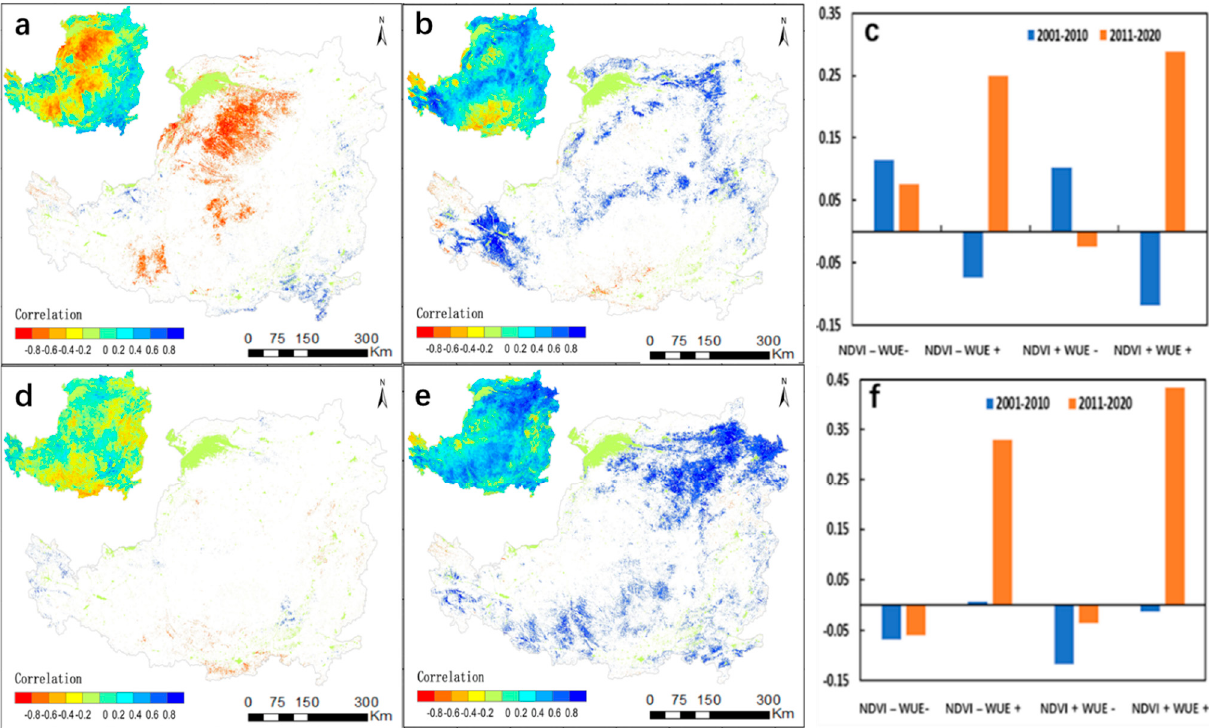
Figure 8. Spatial distribution and statistical images of correlation between precipitation and WUE ( a − c ), WUE, and temperature ( d − f ). ( a , d ) are correlations for 2001 − 2010, ( b , e ) are correlations for 2011 − 2020; The upper right corner is the image without excluding significant p > 0.05 elements. ( c , f ) are statistical maps of the correlation between WUE and meteorological factors.